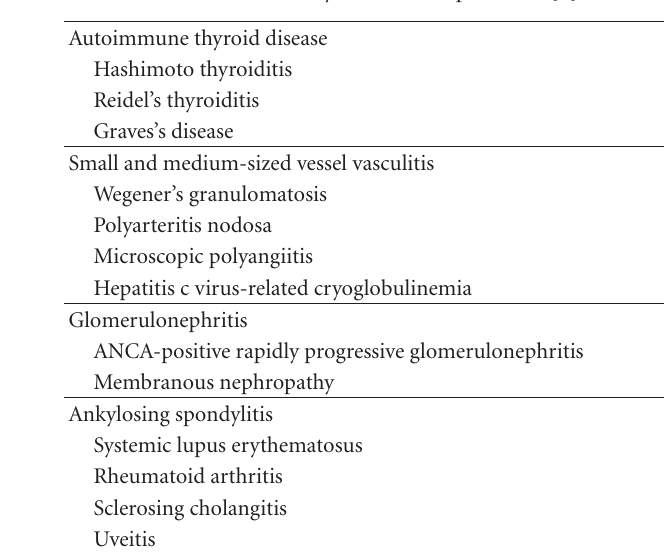
Table 2: Main association between retroperitoneal fibrosis and autoimmune or inflammatory diseases. Adapted from